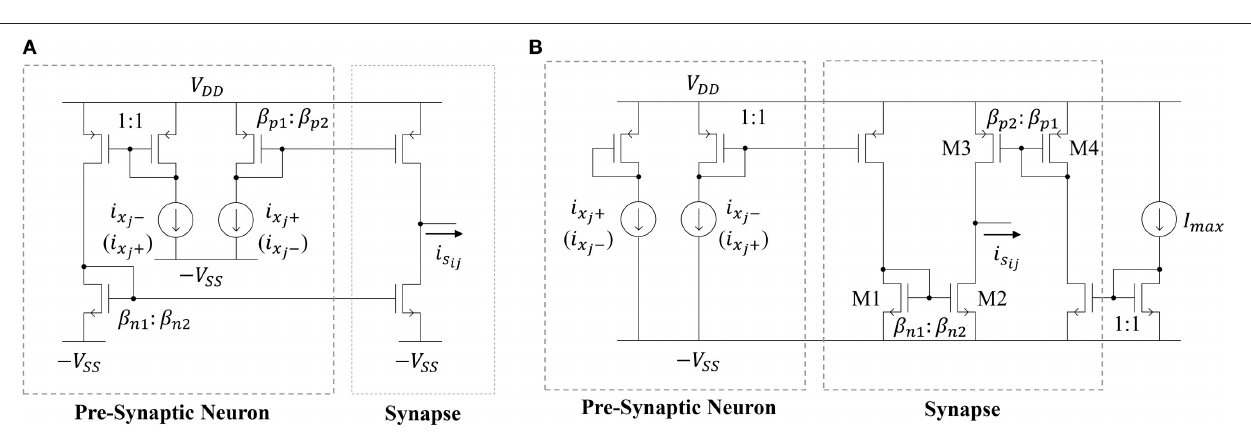
FIGURE 6 | Schematic of (A) a deterministic current-mode constant weight synapse circuit and (B) the proposed synapse circuit that leverages process variations.